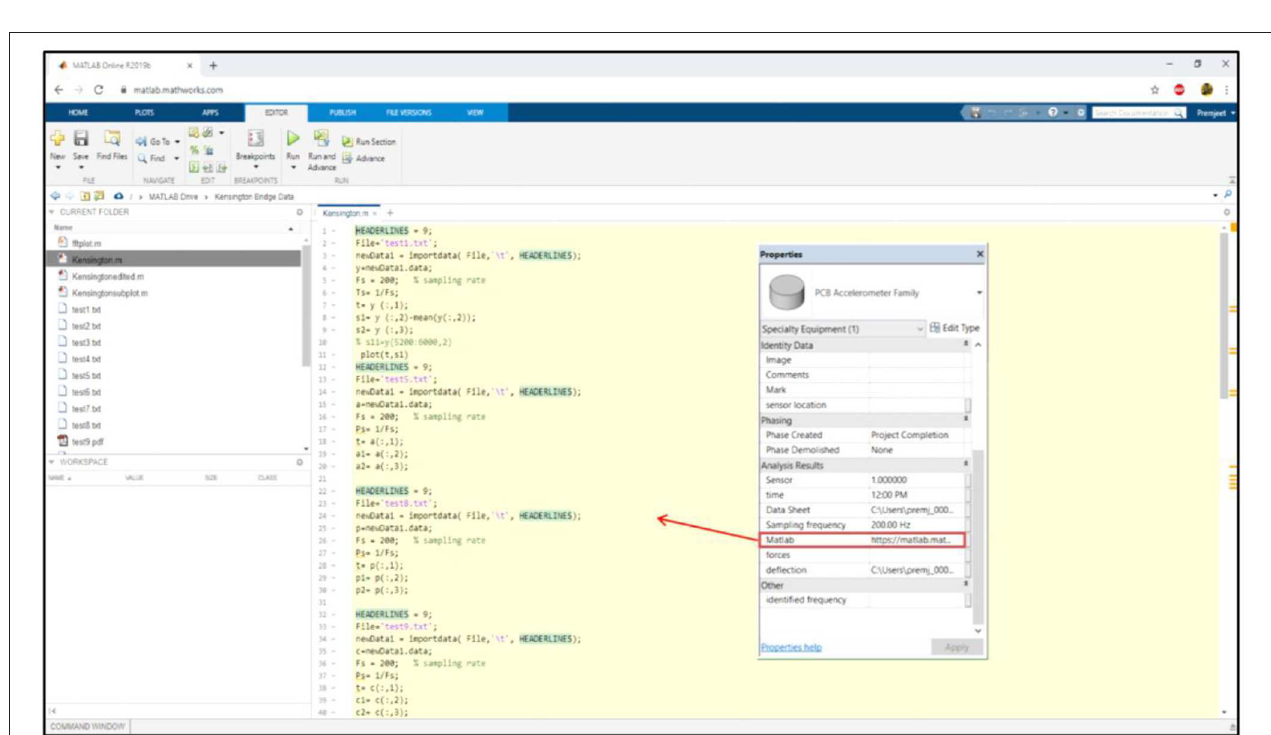
FIGURE 9 | Execution of system identification in REVIT using MATLAB online portal.